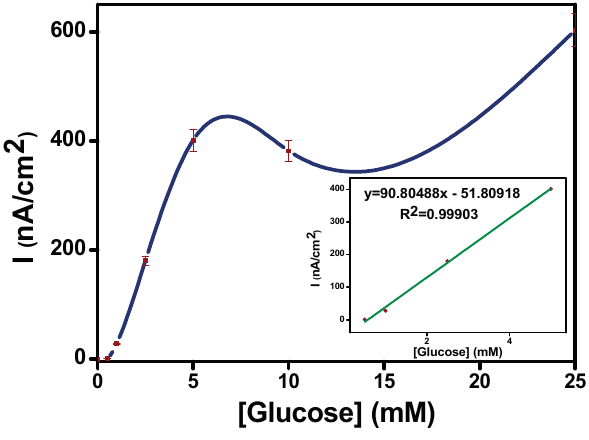
Figure 6. Calibration curve of SNS-NH 2 /SNS-NH 2 -Fc/GOx enzyme electrode (in sodium acetate buffer, 50 mM, pH 4.5, +0.45 V). Table 1. Some features of conducting polymer-based second generation glucose biosensors in the literature.